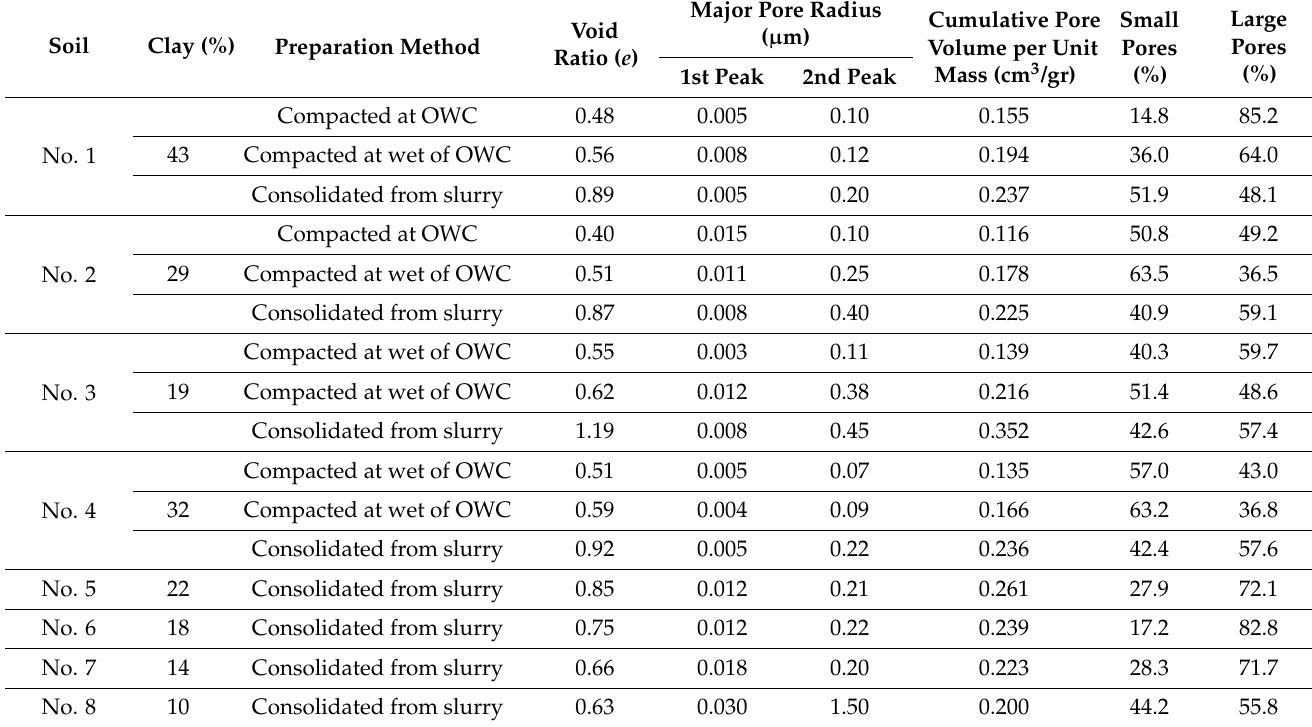
Table 6. Properties of PSD